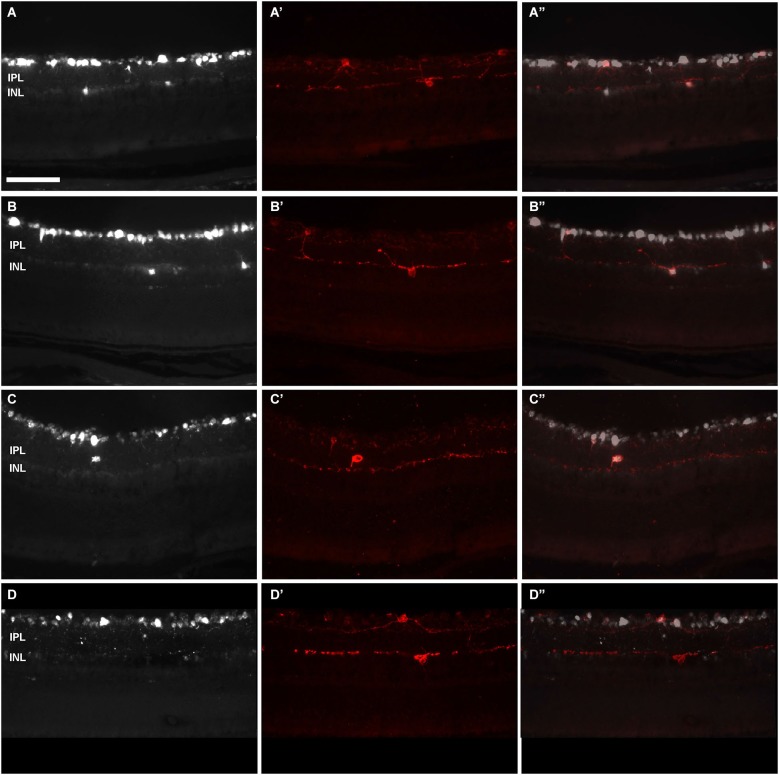
Displaced-ipRGCs in retinal cross sections from pigmented mice. Images acquired from retinal cross-sections showing OHSt (A–D) and melanopsin (A’–D’) signal. (A”–D”) are the corresponding merged images. Retinal ganglion cells were retrogradely labelled with OHSt from the SCi (A–C) or from the ON (D). In (A) and (B) are observed OHSt+ displaced RGCs, out of which two are melanopsin positive (A’,B’). As a rule, d-ipRGCs lay in the inner nuclear layer (A–B”). After scrutinizing the sections from four retinas, one d-ipRGC was found in the inner plexiform layer (C–C”). In (D–D’) is shown an example of a melanopsin positive cell that has not been traced with OHSt from the ON. This is a melanopsin interneuron. IPL: Inner plexiform layer. INL: inner nuclear layer. Scale bar: 100 µm.